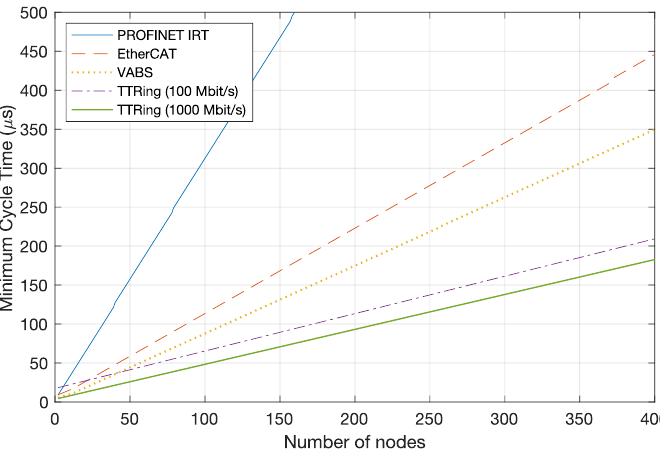
Figure 4. Minimum Cycle Time for several protocols depending on the network